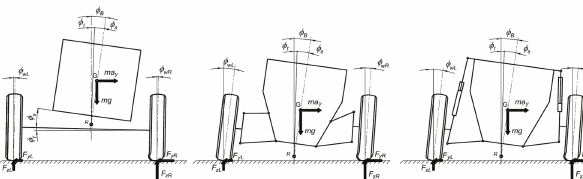
Fig. 1. Comparison of vehicles with different kinds of suspensions on a curvilinear track [own